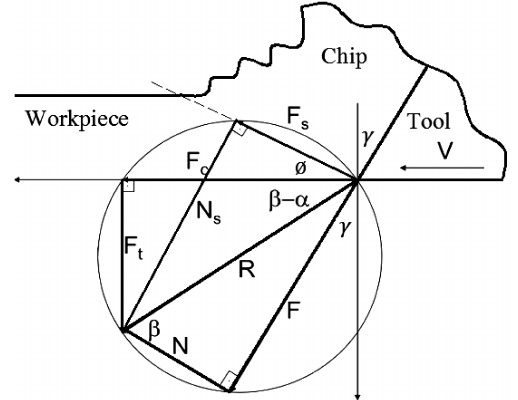
Figure 6. Two-dimensional (2-D) forces system in drilling opera- tions (Merchant’s force circle).